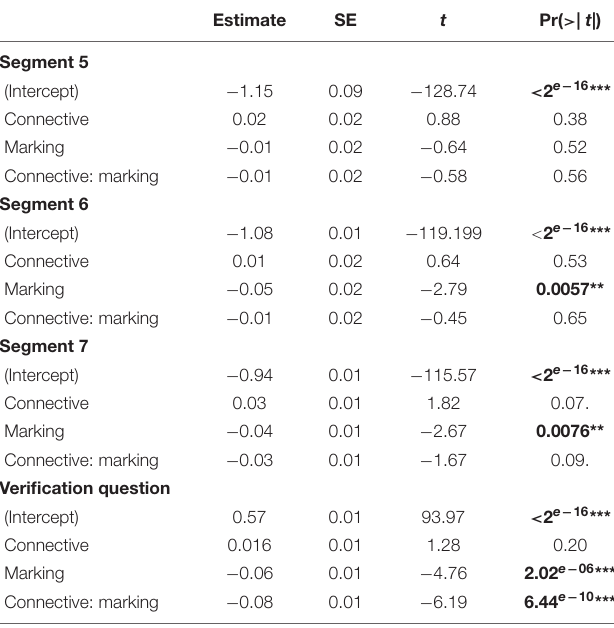
TABLE 4 | Experiment 1, outputs for the models of Segments 5–7 and for the response times to the verification